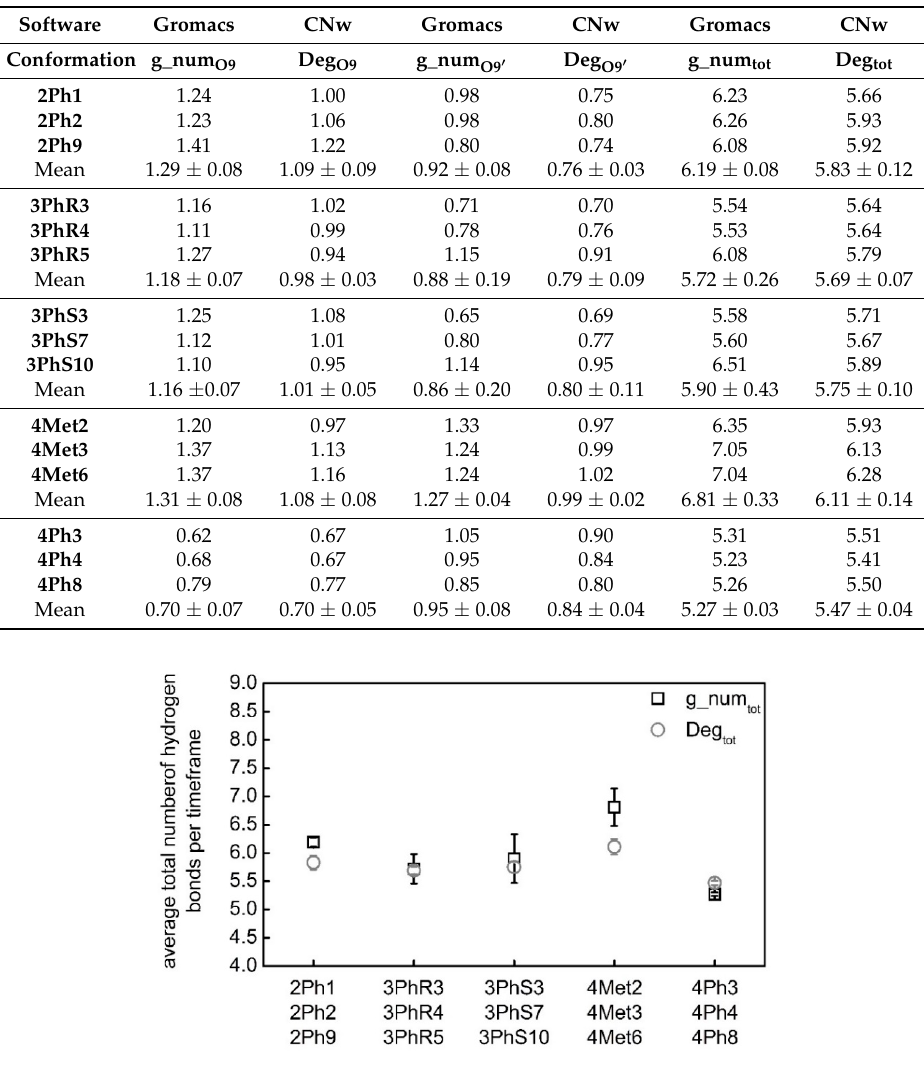
water and visualizes possible steric hindrance attributed to exchanging of the substituents.